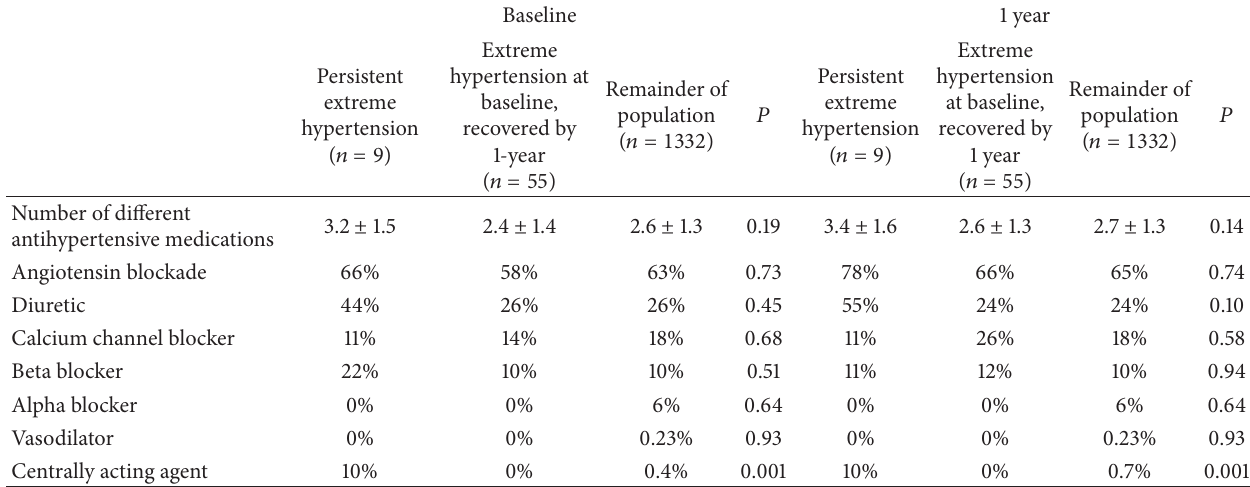
Table 4: Antihypertensive medications at baseline and one year.